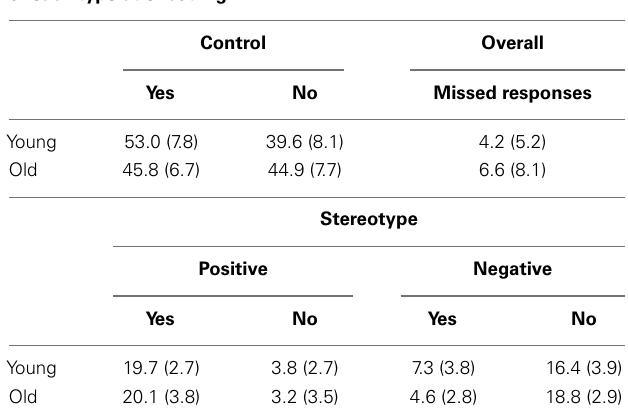
Table 2 | Means and standard deviations for the number of responses of each type at